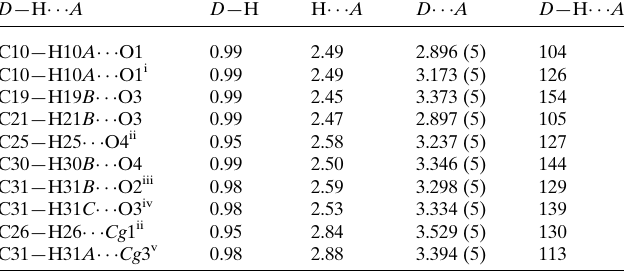
Table 2 Hydrogen-bond geometry (A˚ , (cid:3) ) for 2 . Cg 1 and Cg 3 are the centroids of the C1–C6 and C12–C17 rings, respectively.